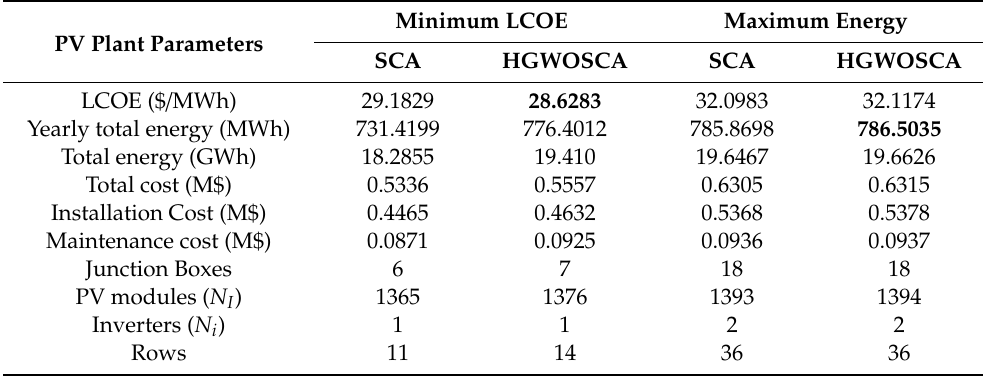
Table 8. Results of optimal design algorithms using semi-hourly measurement